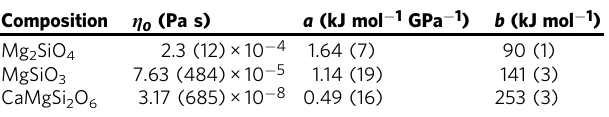
Table 1 Model for the activation enthalpy (Supplementary Fig. 5). Composition η 0 (Pa